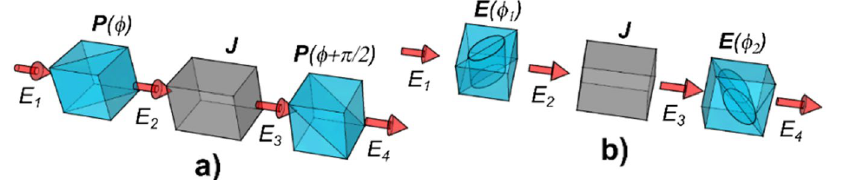
Figure 1. The schematics of the TIPCL evaluation. ( a ) Traditional definition as the throughput of the system J placed between crossed linear polarizers P , ( b ) generalized definition as the throughput of the system J placed between two elliptical polarizers E .